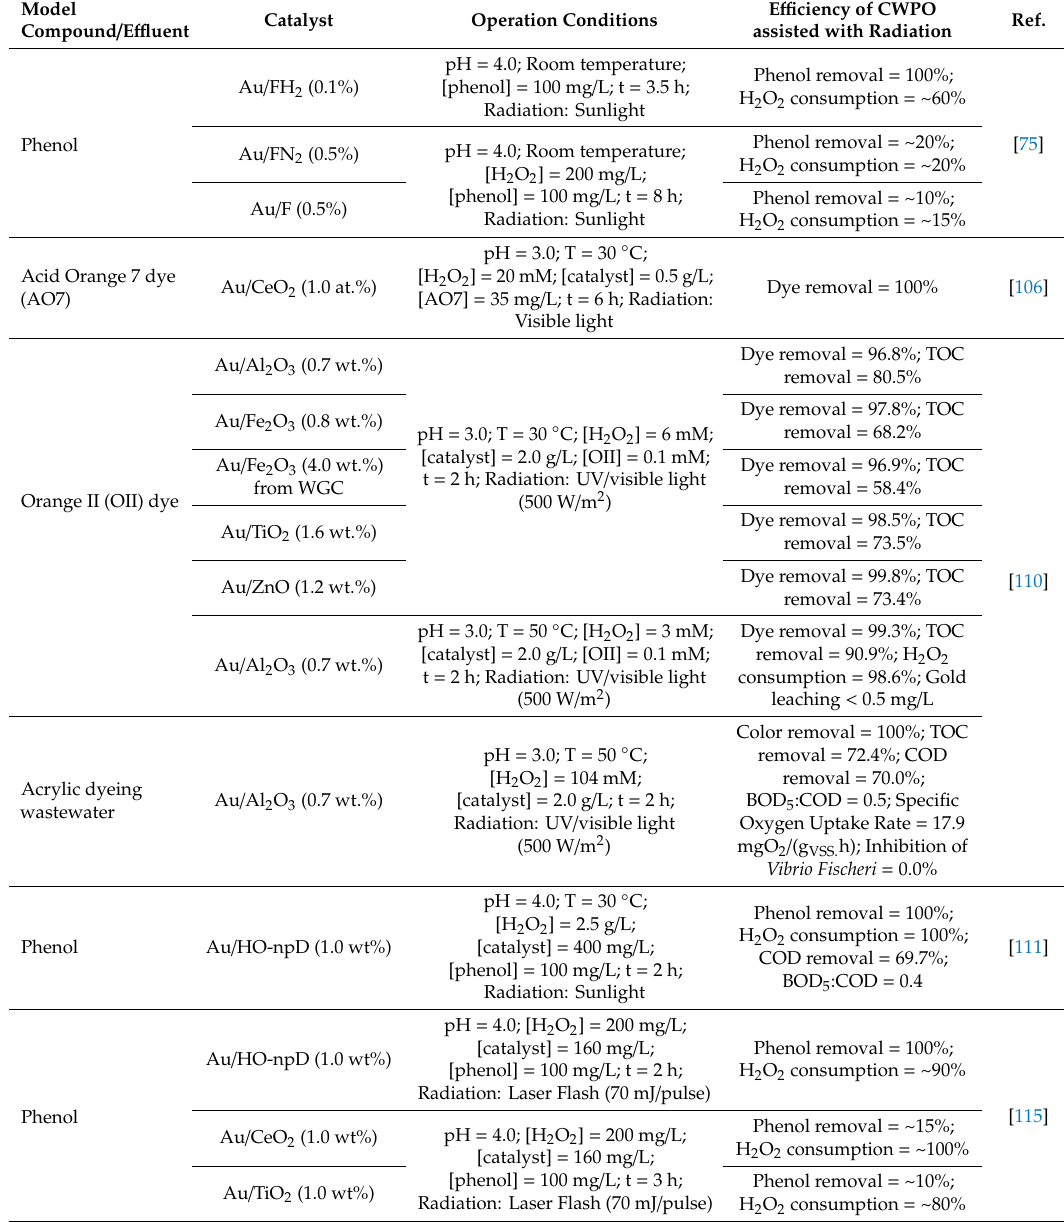
Table 4. Gold catalysts used in CWPO assisted with radiation for model compounds degradation or wastewater treatment, operational conditions, and performances reached.